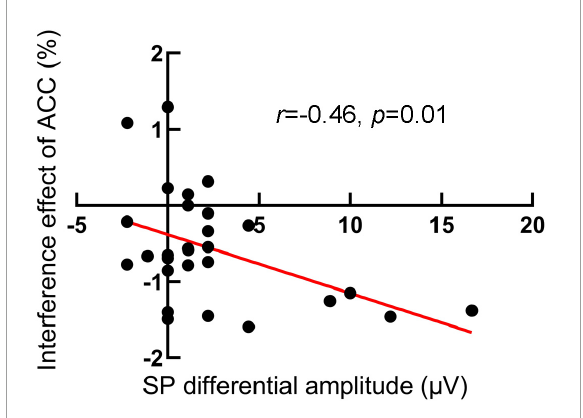
FIGURE6 The scatter plot of the relationship between the interference effect of ACC and SP differential amplitude in the pretest for the RIPC group. The larger the differential SP amplitude, the smaller the interference effects of